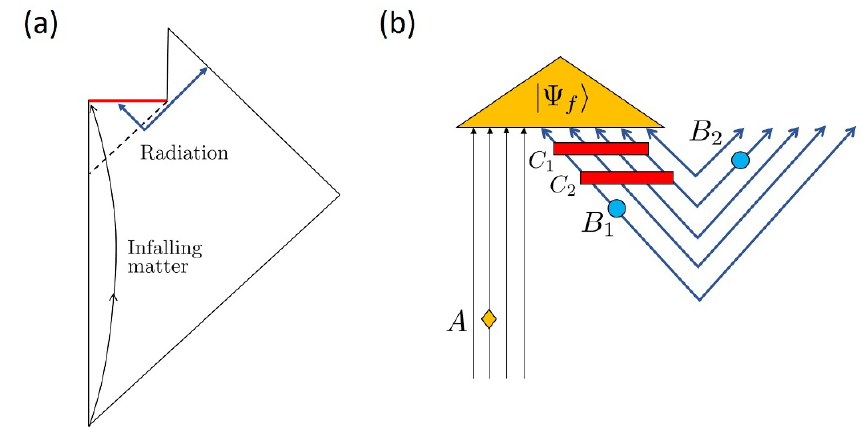
Figure 21 . (a) The Penrose diagram of a Schwarzchild black hole with infalling matter (black curve) and infalling and outgoing Hawking radiation (blue lines). The red line represents singularity. (b) The Horowitz-Maldacena (cid:12)nal state projection model, with the infalling matter and infalling Hawking qubits projected to a pure state at the singularity. A; B 1 ; B 2 are small regions of infalling matter, infalling radiation and outgoing radiation, respectively. C 1 ; C 2 are bigger regions of